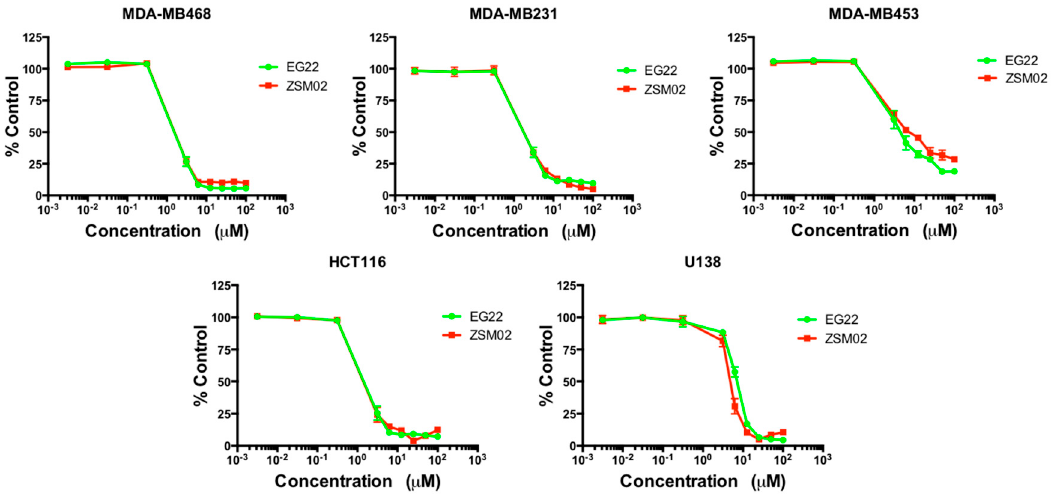
Figure 7. Growth inhibition activity of compounds 8a (EG22) and 9a (ZSM02).